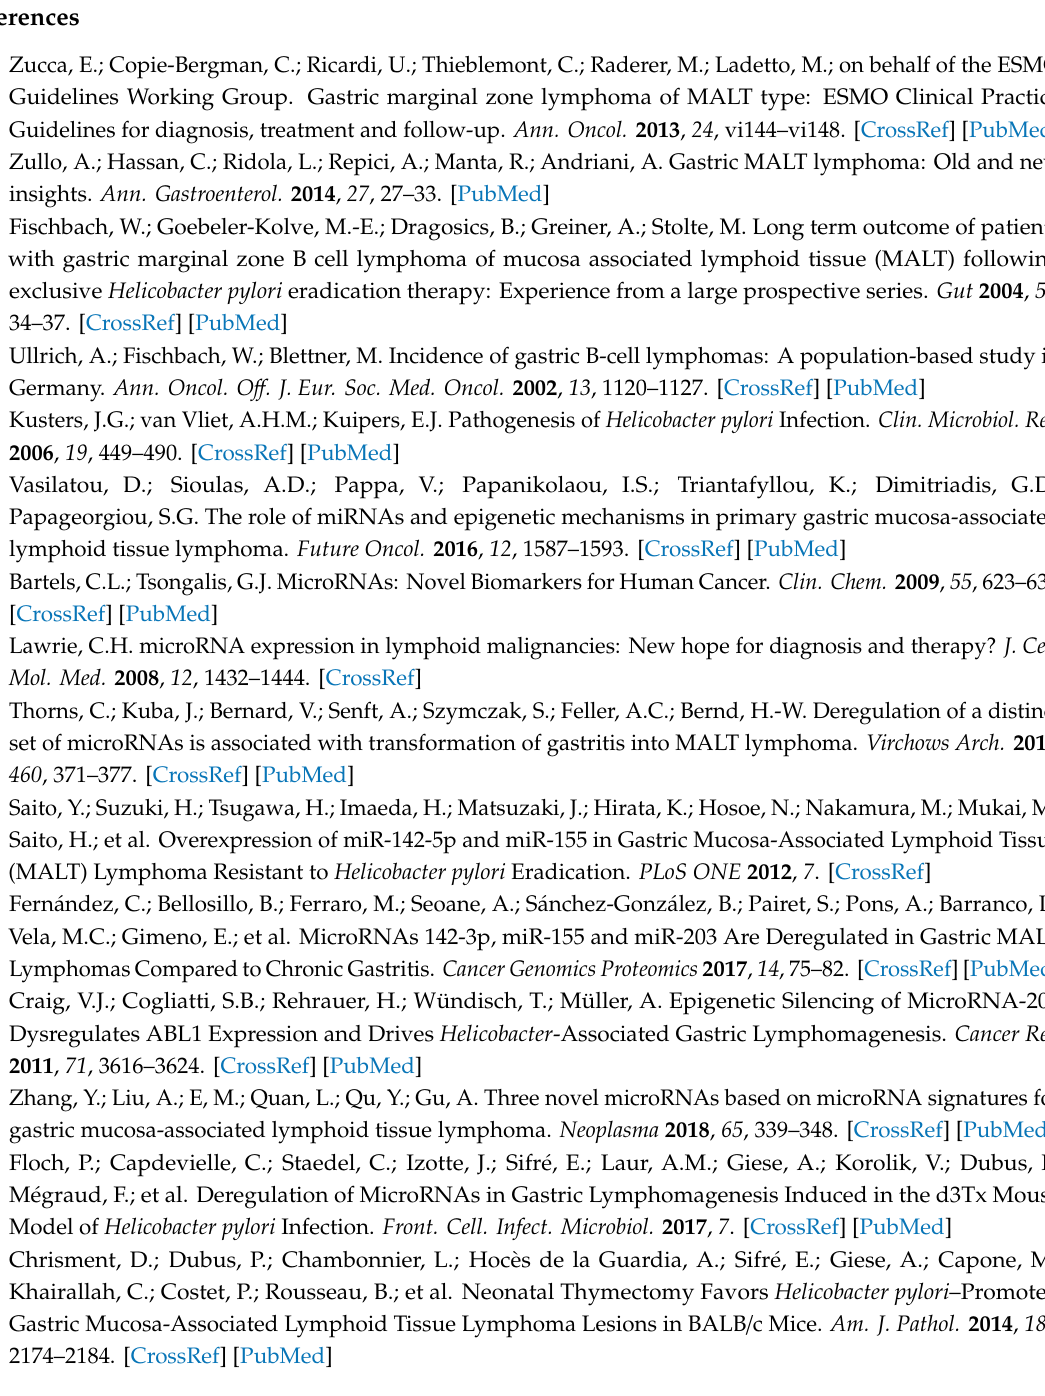
Table S1: List of the specific primers (Qiagen) used for each miRNA amplification by